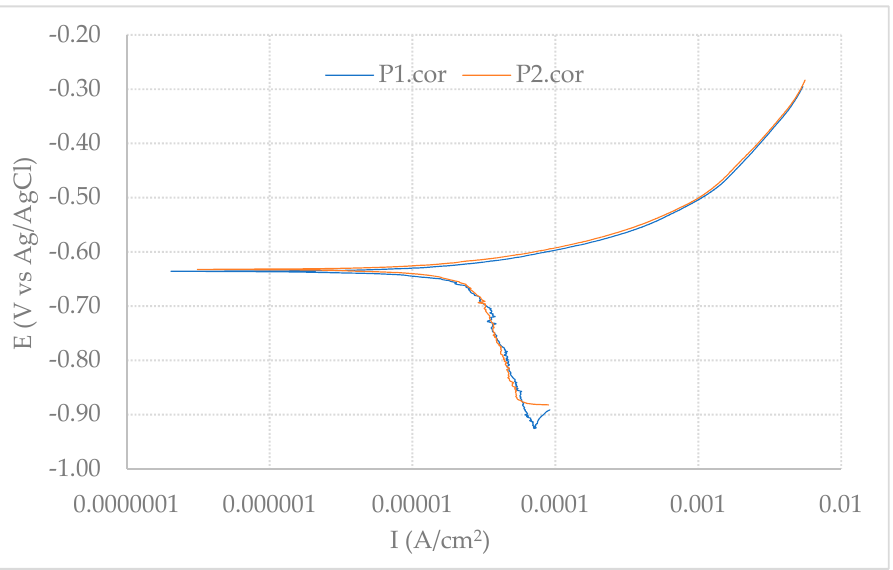
Figure 2. Polarization curves for the polished samples in artificial seawater (open to air) at 20 °C.